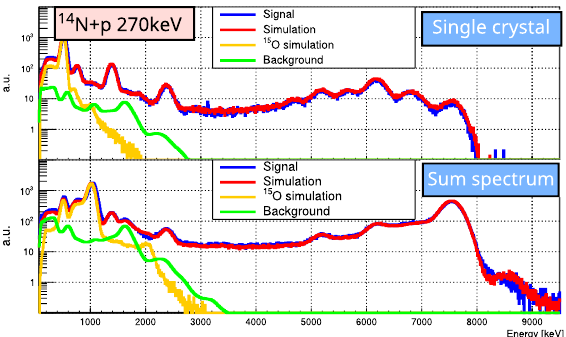
Figure 2. Comparison of simulated (red) and measured (blue) spectra of 14 N( p ,γ ) 15 O 270keV reso- nance. In green and yellow are represented environmental background and 15 O decay spectra respec- tively, included in the simulation.